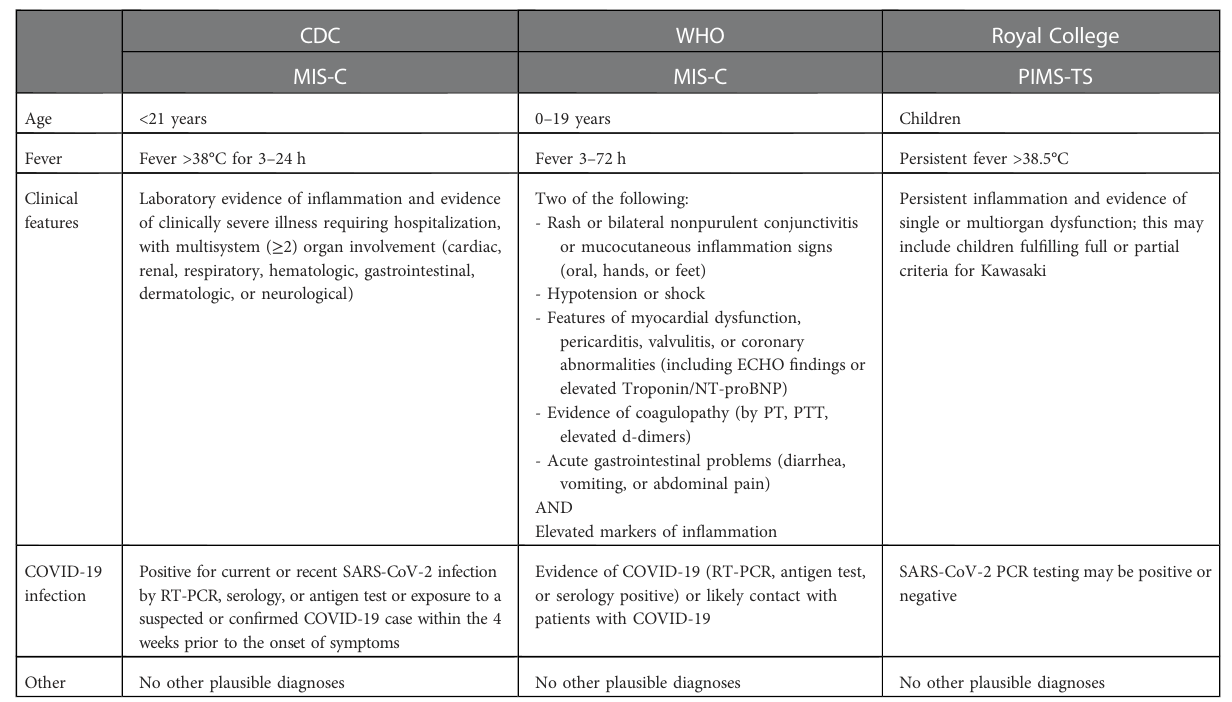
TABLE 2 Diagnostic criteria of MIS-C (CDC, WHO, and Royal College) (10 –